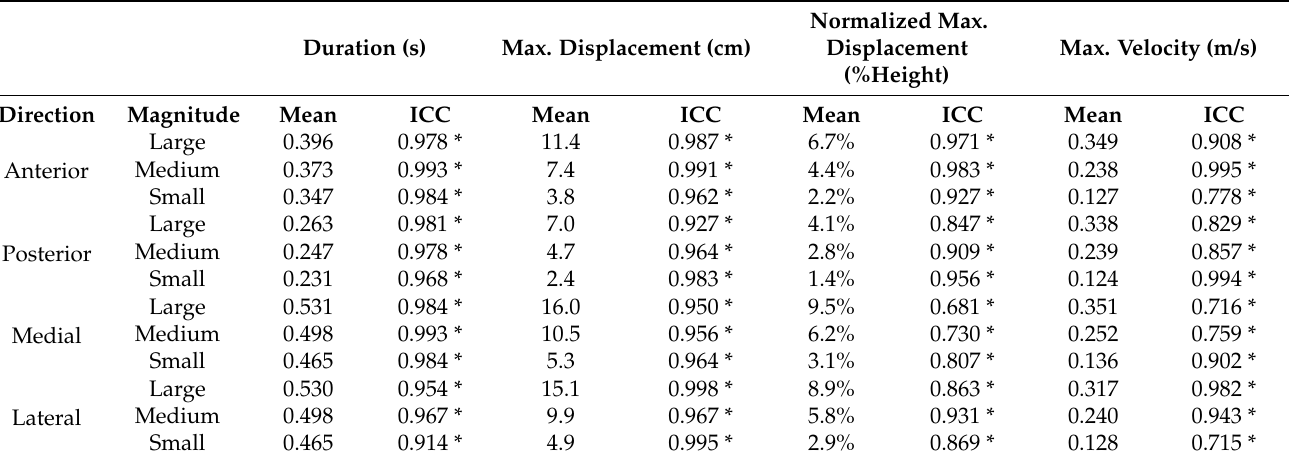
Table 3. Mean and ICC values of pulling parameters examining the reliability of the waist-pull system ( n =